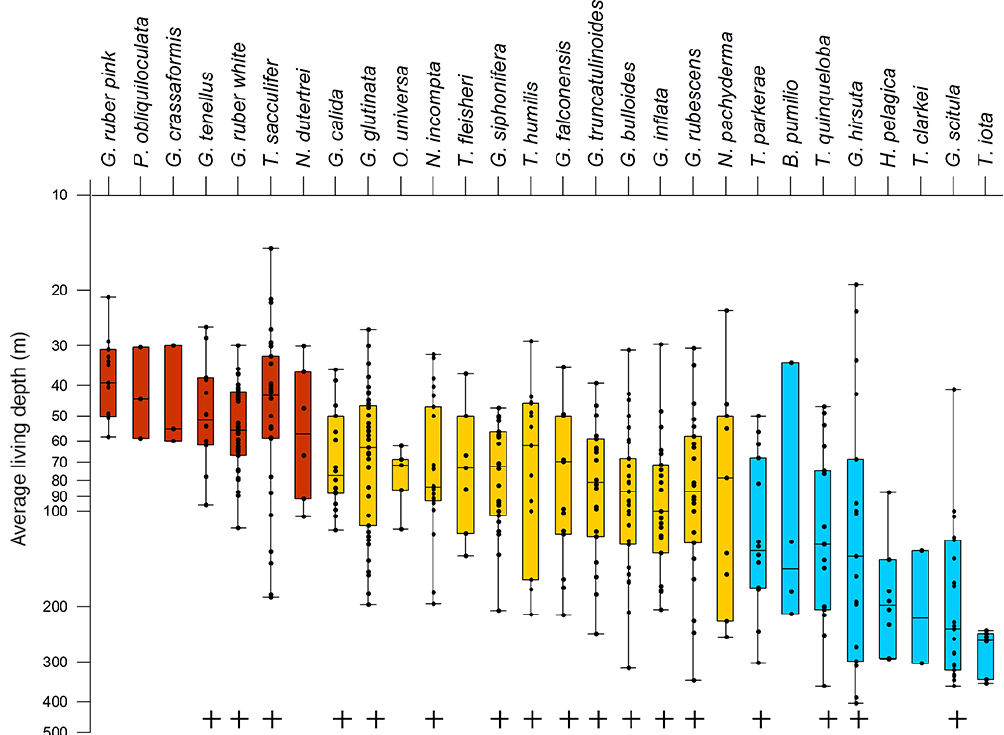
Figure 7. Average living depths of the 28 most abundant species of planktonic foraminifera obtained from analysis of 43 vertically resolved plankton hauls (Fig. 1, Table 1). Values are only shown for stations where at least five individuals of a given species have been counted. The box and whiskers plots are highlighting the median and the upper and lower quartiles. The species are ordered according to their mean ALD. Dots represent individual observations. Colors are used to highlight species with similar depth preferences; changes in color coding reflect large and consistent shifts in ALD. Crosses underneath the box plots indicate species with variable living depth and sufficient number of observations, such that they could be included in an analysis of factors controlling their living